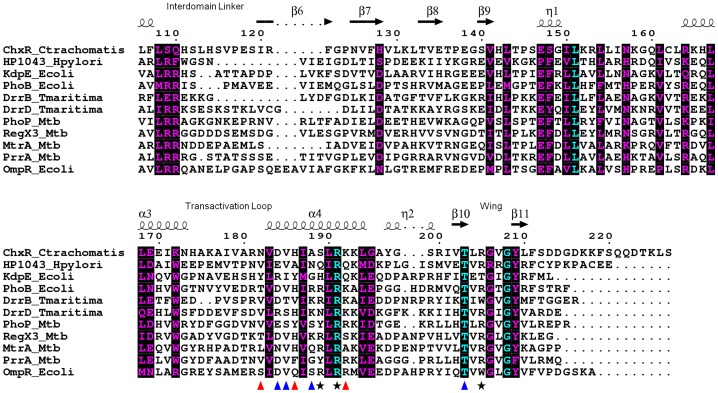
Limited structure-based sequence alignment of OmpR/PhoB subfamily Response Regulator effector domains.Numbers above the sequences correspond to C. trachomatis ChxR. The secondary structure of ChxR is shown above the alignment. Residues are colored according to conservation (cyan = identical and purple = similar) as judged by the BLOSUM62 matrix. Red triangles below the sequences correspond to amino acid side chains identified by ChxR mutagenesis that are involved in DNA binding, blue triangles correspond to DNA interacting side chains identified within a single OmpR/PhoB subfamily member while black stars represent DNA interaction sites within multiple OmpR/PhoB subfamily members [41], [43]–[45]. Sequences used within alignment are comprised of OmpR/PhoB subfamily members with extensive structural and/or functional studies. Accession numbers are detailed in the Materials and Methods section.